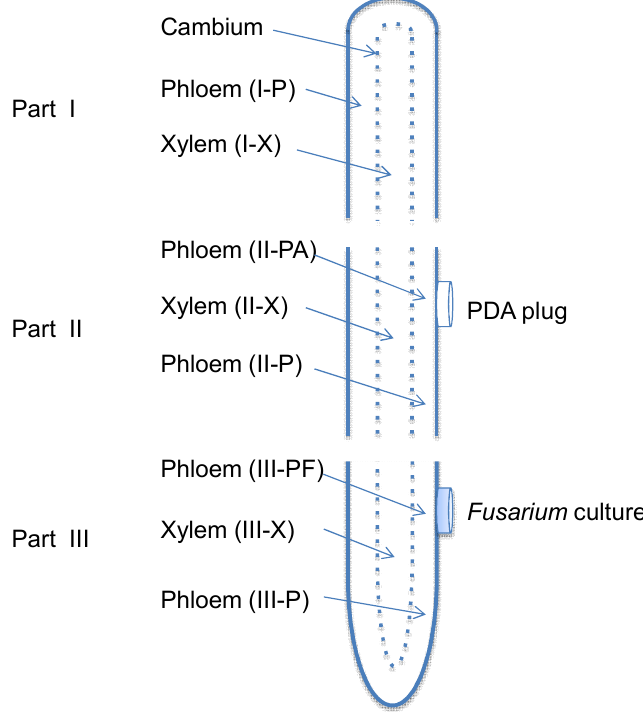
Figure 7. Schematic diagram of xylem (X) and phloem (P) tissues of a dissected taproot of American ginseng showing the three parts (I, II, and III) of sampling and inoculation with Fusarium solani or F. oxysporum